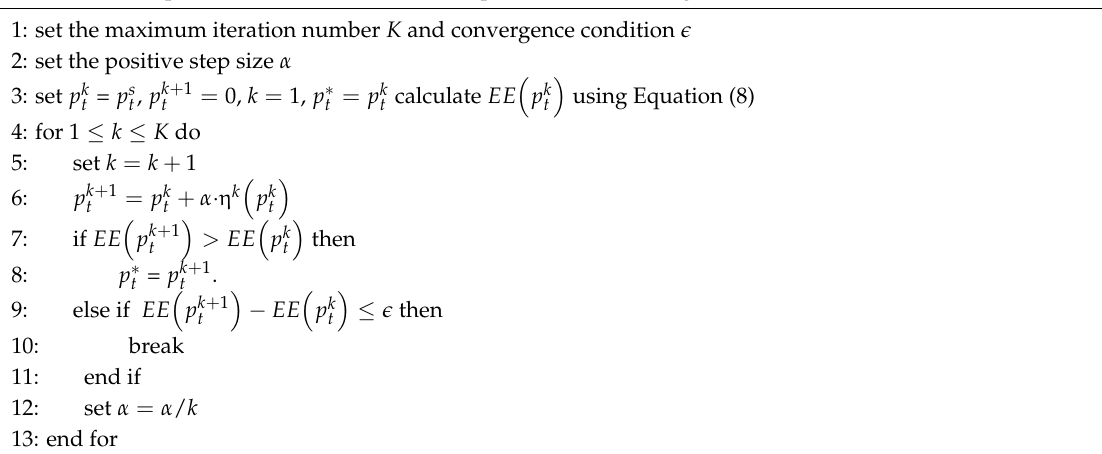
Algorithm 2: Optimization of the transmission power based on the gradient